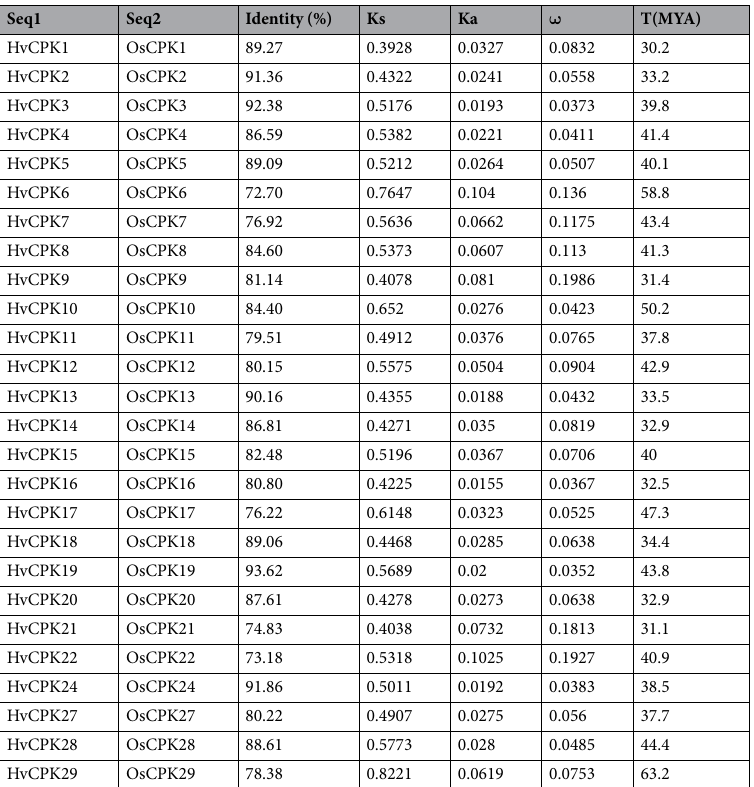
Table 3. Estimated divergence time between bayley–rice CPK